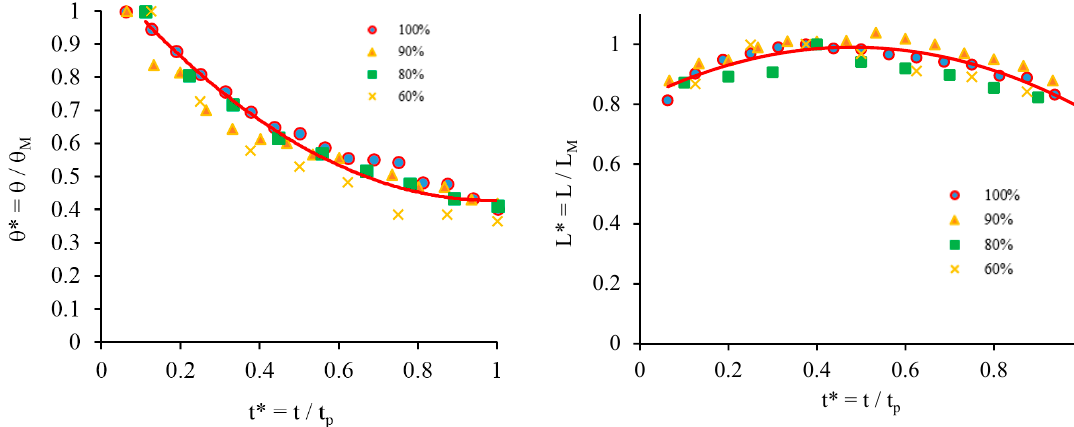
Figure 6. Contact angle and droplet base diameter dimensionless profiles for different concentrations of surfactant on a dry dish sponge.